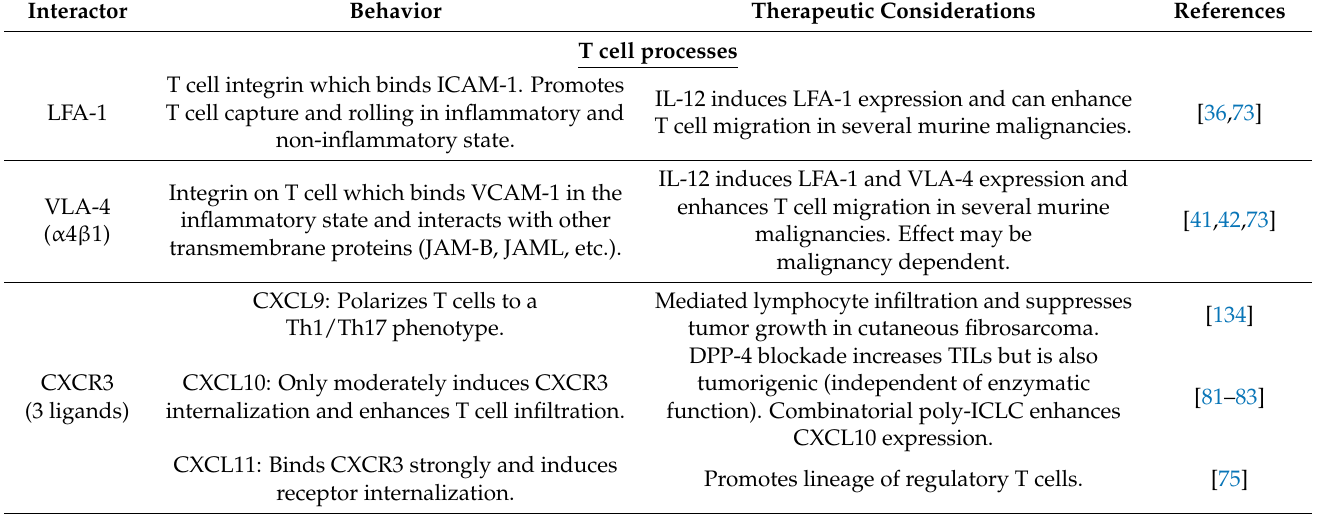
Table 1. A summary of selected factors that may enhance trafficking and infiltration of T cells across the BBB. Interactor Behavior Therapeutic Considerations T cell